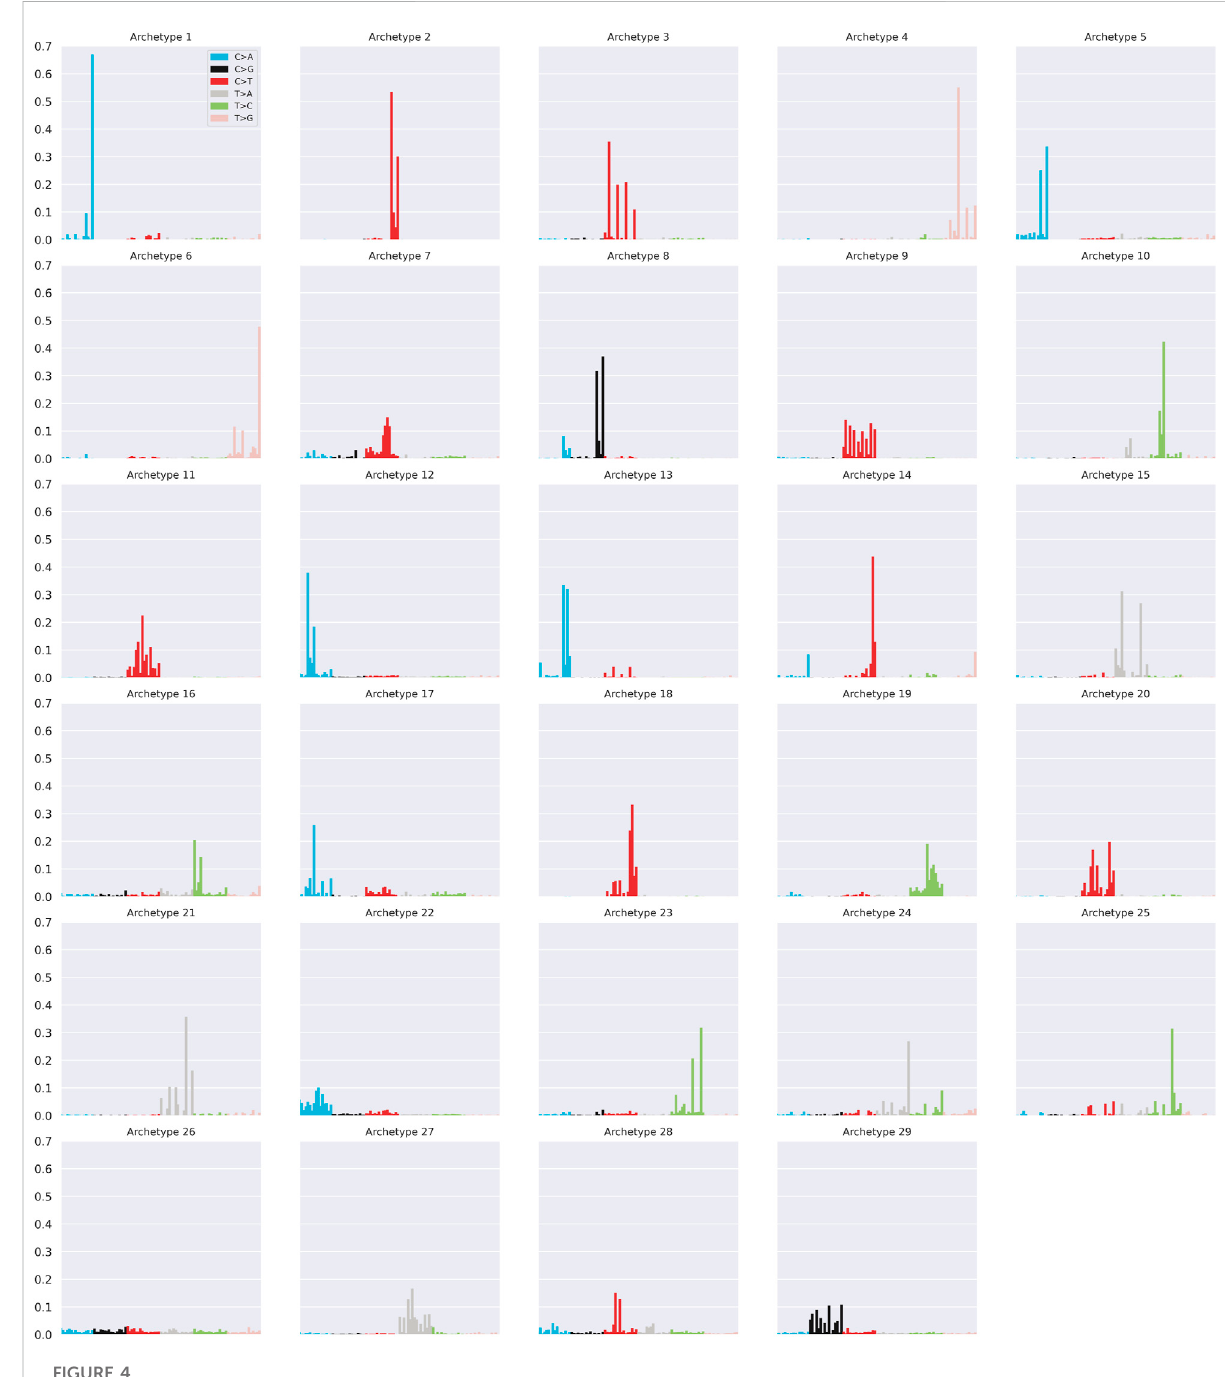
FIGURE 4 Summary of the 29 archetypal pro fi